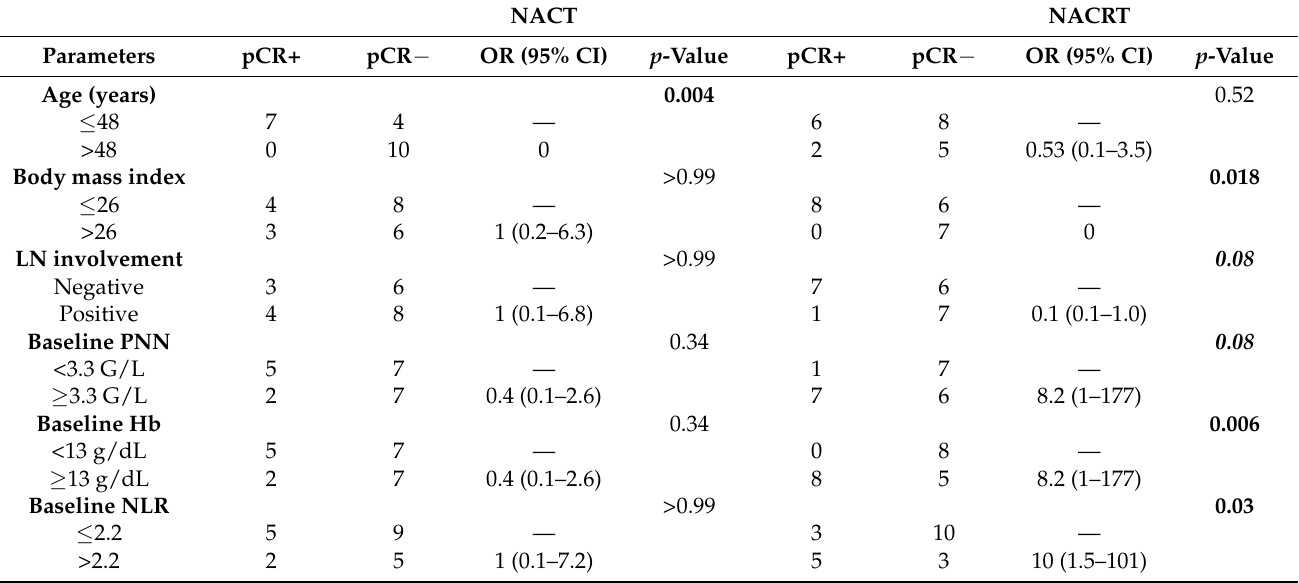
Table 3. Associations between clinical and peripheral blood parameters and response to neoadju- vant